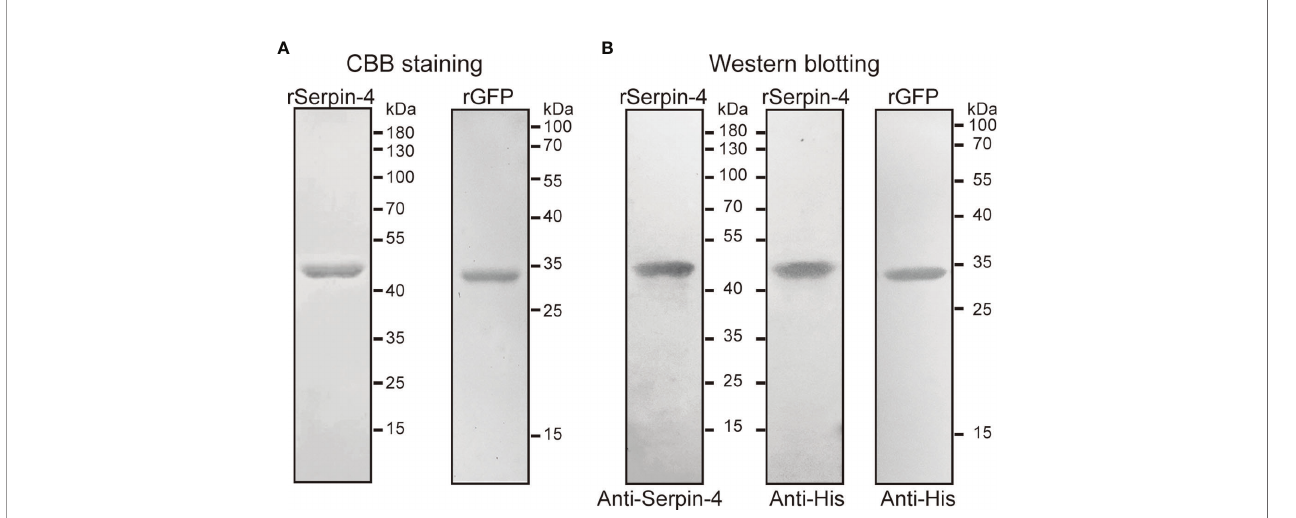
FIGURE 3 | SDS – PAGE (A) and immunoblot analysis (B) of puri fi ed recombinant serpin – 4 and GFP. The puri fi ed recombinant serpin – 4 (250 ng) or recombinant GFP (250 ng) was treated with SDS sample buffer containing DTT, separated by 10% or 15% SDS – PAGE and subjected to Coomassie brilliant blue staining or immunoblotting with anti – His or anti – serpin – 4 as primary